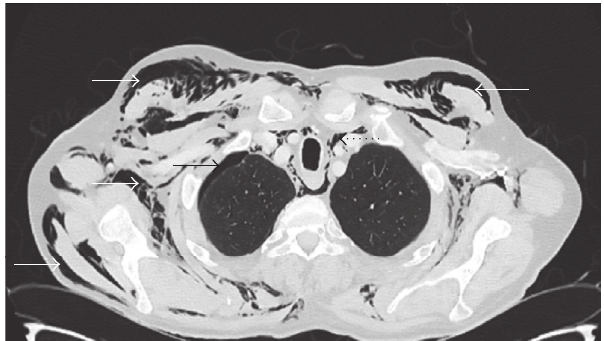
Figure 1: CT revealed diffuse subcutaneous emphysema (white arrows), pneumomediastinum (black dotted arrow), and a small pneumothorax of the right lung (black arrow).